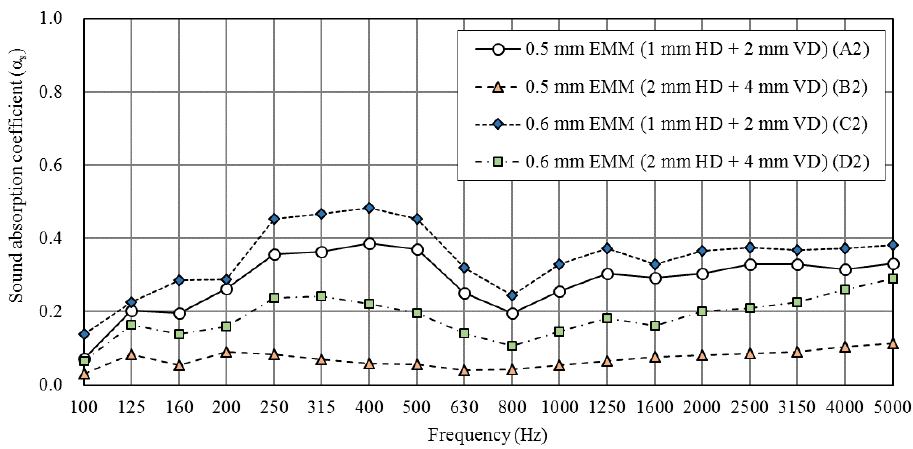
Figure 7. The sound-absorption coefficient of EMM with a 260 mm cavity.